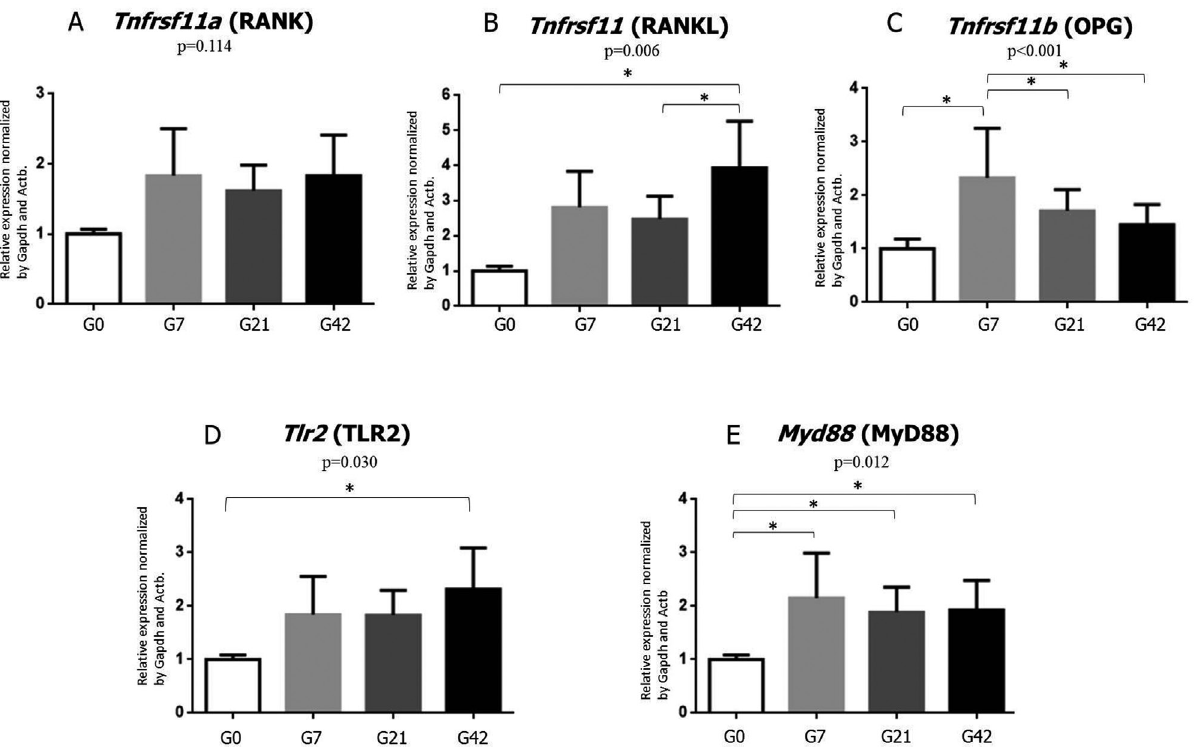
Figure 5- Graphical representation of mRNA expression distribution. Tnfrsf11a (A), Tnfrsf11 (B), Tnfrsf11b (C), Tlr2 (D) and MyD88 (E) in mice after AP induction in the periods of 0, 7, 21 and 42 d. The asterisk demonstrates statistical difference